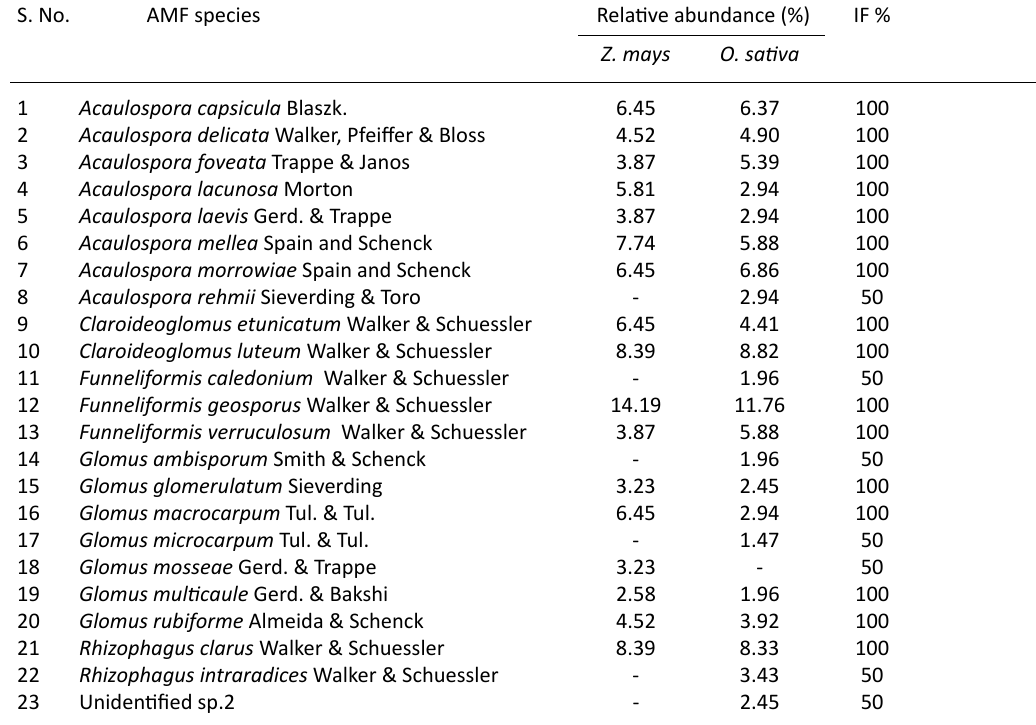
Unidentified sp.1 Table 4. AMF species isolated from trap cultures (un-mined site derived inoculum) with their relative abundance and isolation frequency (IF) using Z. may s and O. sativa as trap plants S.